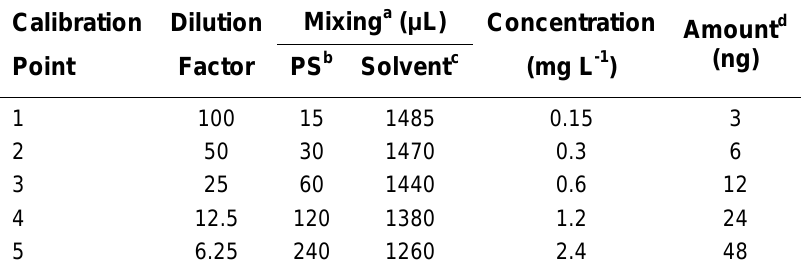
Preparation of WS Containing 15